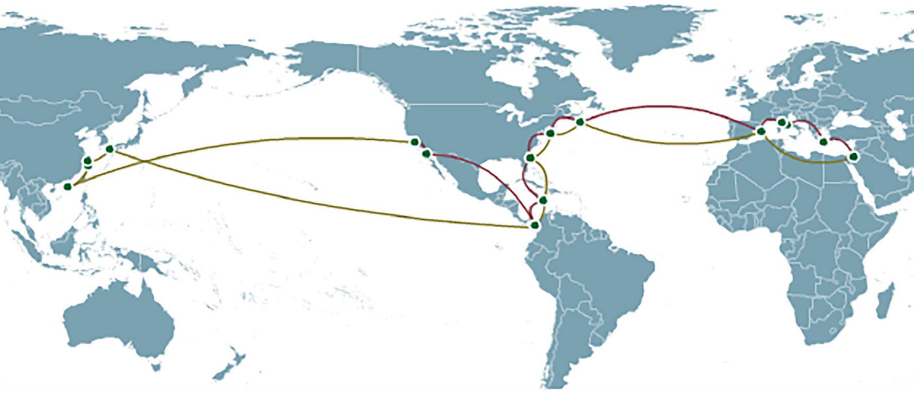
Figure 7. Zim’s pendulum route in 2011 (ZIM